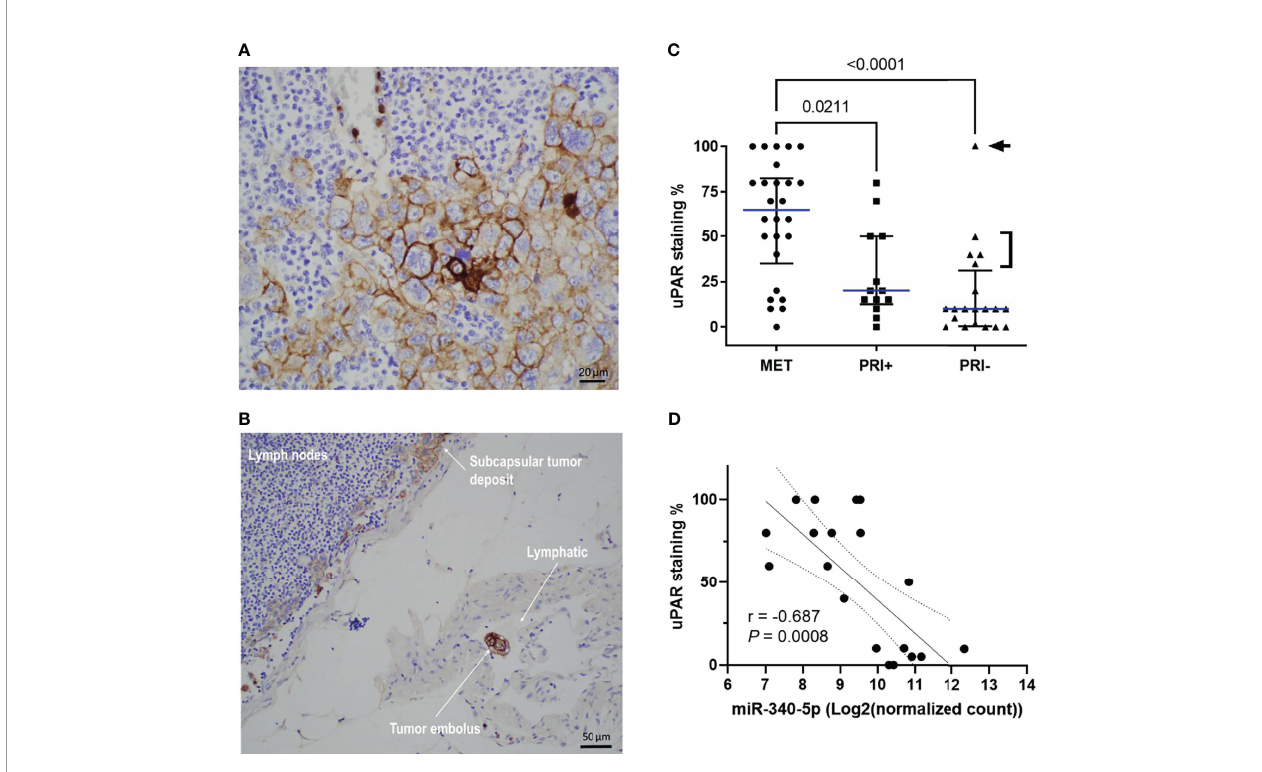
FIGURE 5 | uPAR protein expression is increased on metastatic tumors and correlates with miRNA-340-5p expression. Representative photomicrographs showing uPAR staining in (A) a metastatic deposit in the lymph node of Patient 2 and (B) a positively stained embolus as well as staining in the subcapsular tumor deposit from the lymphatic of patient 2. (C) Scatter plot of uPAR IHC scores of all patient specimens stained (n = 58 total) showing cohort median values (blue line) with interquartile ranges (refer to Table S3 for individual patient values). p -values shown were derived using a Kruskal – Wallis test for multiple comparisons with uncorrected Dunn ’ s posttest. Arrowhead denotes patient 37 who had a 160 mm diameter × 70 mm thick PRI-. Bracket denotes PRI- tumors with >50-mm diameter and PNI. (D) Scatter plot showing relationship between uPAR staining scores and hsa-miR-340-5p normalized gene count (n = 20 pairs; refer to Table S6 ) and show Rho (Spearman ’ s) correlation, p -value, and interquartile range for the